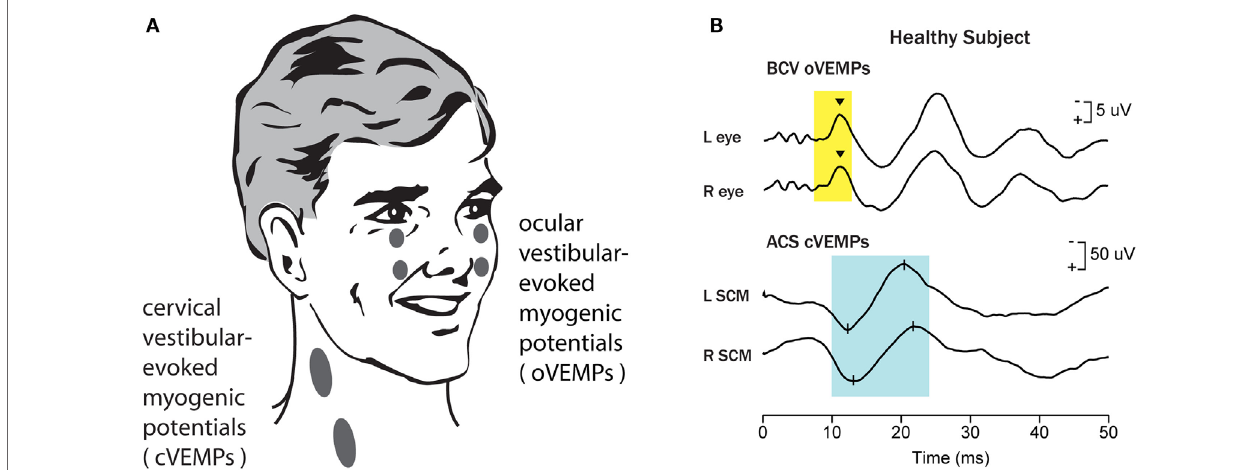
FigURe 1 | Vestibular-evoked myogenic potentials (VEMPs). There are a host of VEMPs since vestibular input projects indirectly to many muscle groups. The two VEMPs which have received the most attention are cervical vestibular-evoked myogenic potentials (cVEMPs) and ocular vestibular-evoked myogenic potentials (oVEMPs). cVEMPs are recorded by surface electromyographic (EMG) electrodes over the tensed sternocleidomastoid muscles (SCMs) (11). The cVEMP consists of a short latency (13 ms from onset to peak) positive (i.e., inhibitory) EMG potential in response to high-intensity air-conducted sound (ACS) or bone-conducted vibration (BCV) (15). oVEMPs consist of a small (5–10 µV) negative (i.e., excitatory) potential recorded by surface electrodes on the skin beneath the eyes from the inferior oblique in response to BCV or ACS (12, 13). To record the oVEMP, the subject must be looking up. (A) Electrode placement for oVEMPs and cVEMPs; the ground electrode (not shown) is typically on the chin or sternum. (B) [Reprinted from Iwasaki et al. (16) © 2009, with permission from Elsevier.] Typical oVEMP and cVEMP traces for a healthy subject: the magnitude of the n10 response is approximately equal beneath both eyes for the oVEMP, and similarly the magnitude of the p13–n23 response is approximately equal in both SCMs for the